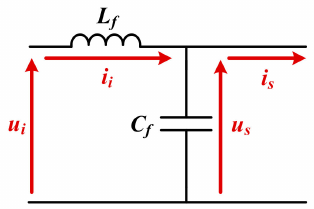
Figure 3. Schematic diagram of LC filter (single